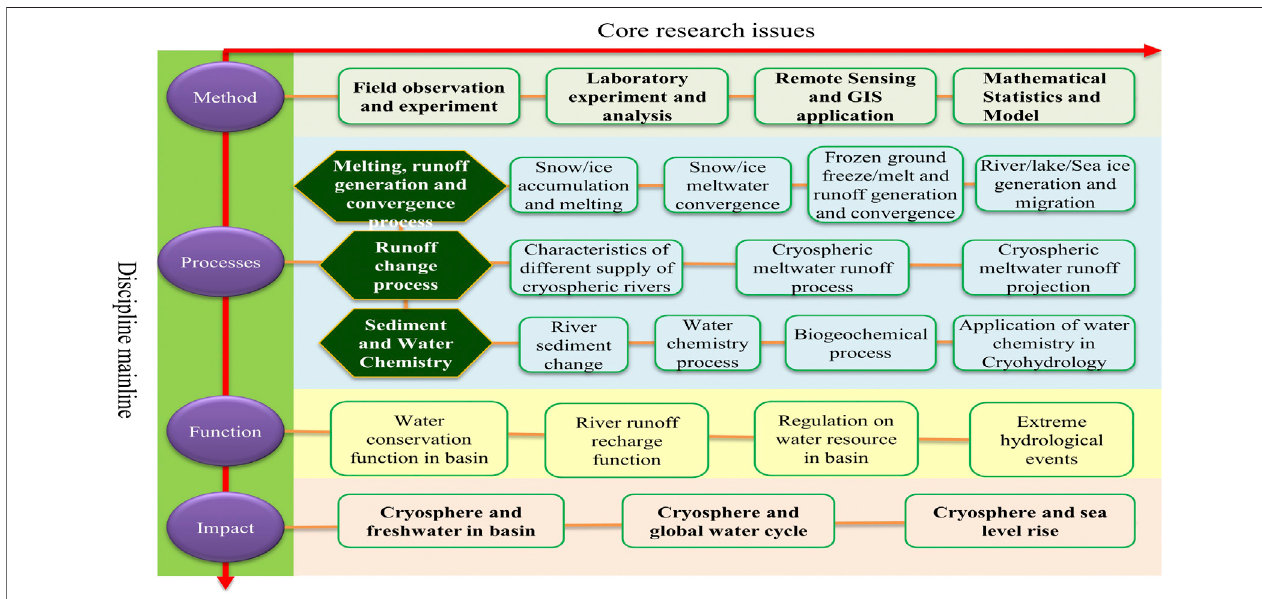
FIGURE 3 | The core research issues of cryohydrology along the discipline mainline which primarily include method ( in situ observation, laboratory experiment, remotesensingapplication,andstatistics/model),processes(melting,runoffgenerationandconvergence,runoffchanges,andsedimentandchemistry),function(water conservation, runoff recharge, regulation, and extreme events), and impact (freshwater in basin, global water cycle, and sea level rise).